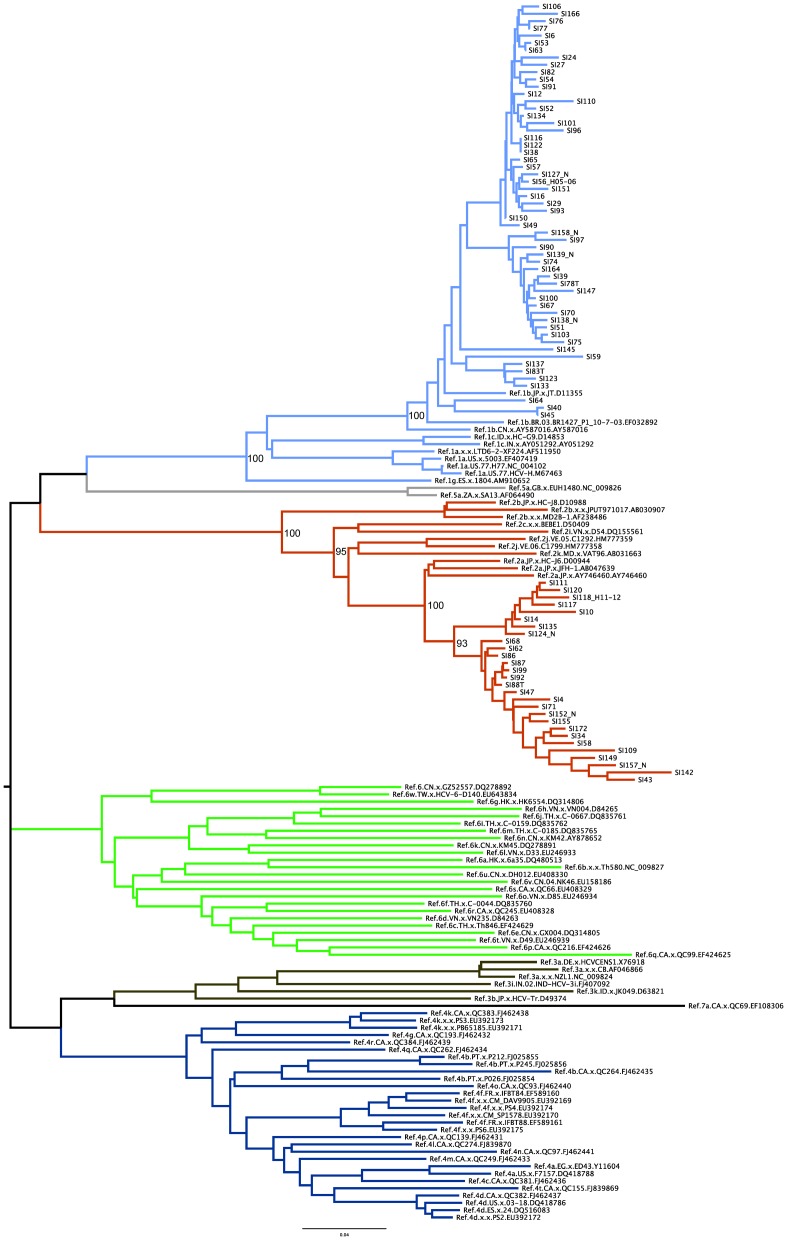
Maximum-Likelihood phylogeny estimated from NS5B sequences (H77 positions 8261–8639).Bootstrap support values are only shown for the major ancestral nodes of interest. Reference HCV sequences are indicated by genotype followed by their Genbank accession numbers. Similar phylogenetic patterns were observed for C/E1 (not shown).